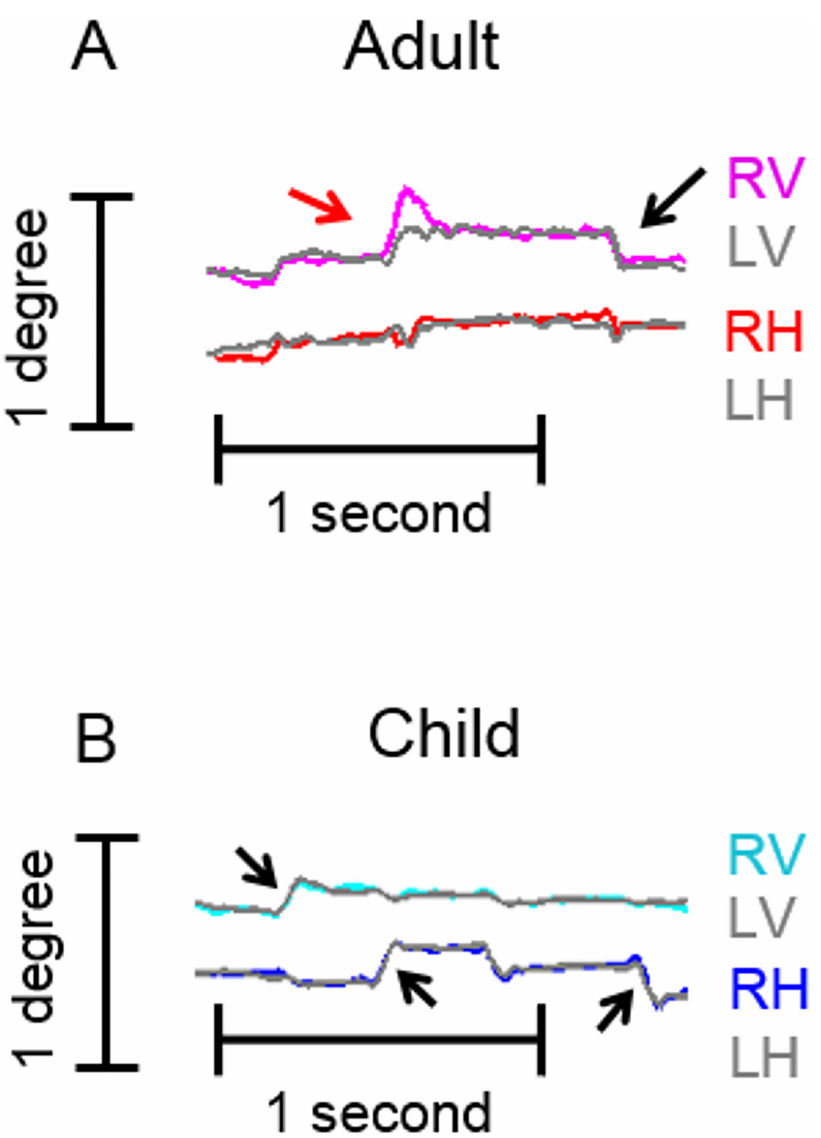
Fig 1. Example of fixational saccade and drifts in a 1.5-second epoch of eye positions recorded from an adult and a child. Horizontaland vertical eye positions were recordedfrom the right and left eye (LV: left vertical; RV: right vertical; LH: left horizontal; RH: right horizontal). Eye positionsare plotted on y-axis while x- axis depicts the corresponding time. Coloredtraces depict right eye position whilegray traces illustrate the left eye. Arrows depict fixational saccades. (A) An exampleof fixational eye movementsin an adult subject (subject 20 in Table 1). The fixationalsaccade has different amplitudes in the vertical direction(red arrow) betweenthe two eyes suggestinga disconjugacy. (B) An exampleof fixationaleye movement in a child (subject 7 in Table 1). Arrows depict fixationalsaccade. The amplitudeof the fixational saccade is